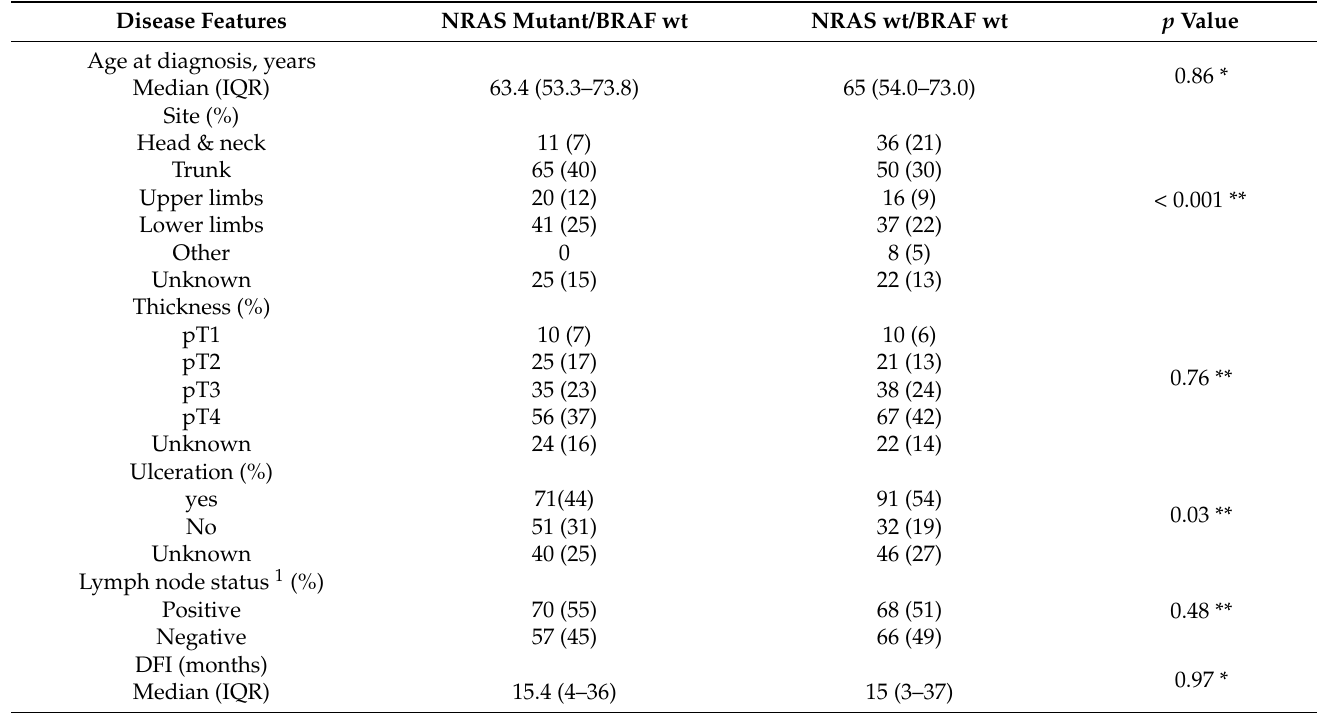
Table 2. Main disease characteristics of the two cohorts at melanoma onset.